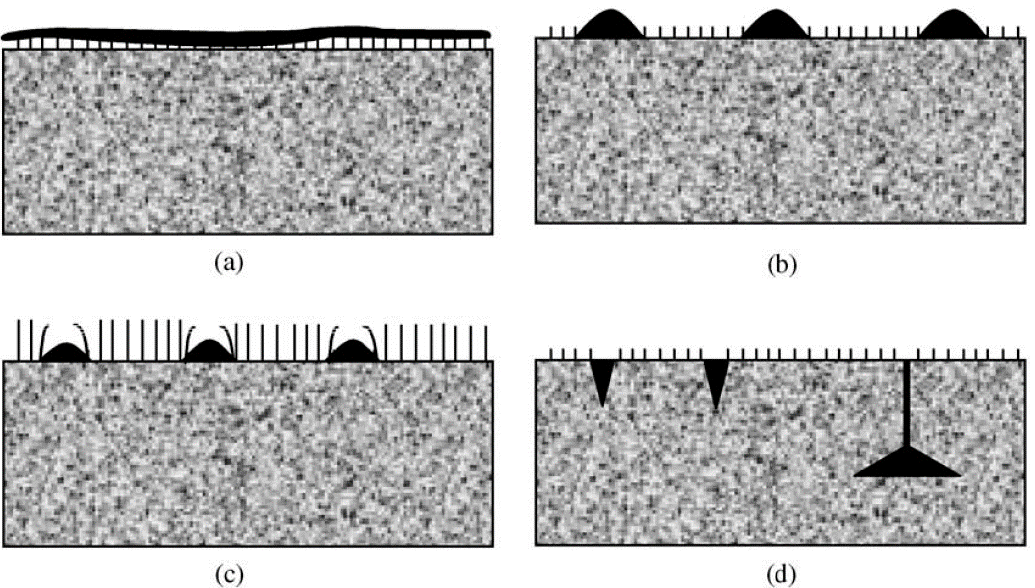
Figure 1. Schematic representation of slurry application by ( a ) surface broadcast, ( b ) trailing hose, ( c ) trailing shoe, and ( d ) shallow or deep injection. Reproduced with permission from [29]. Copyrisht Elsevier, 2002.